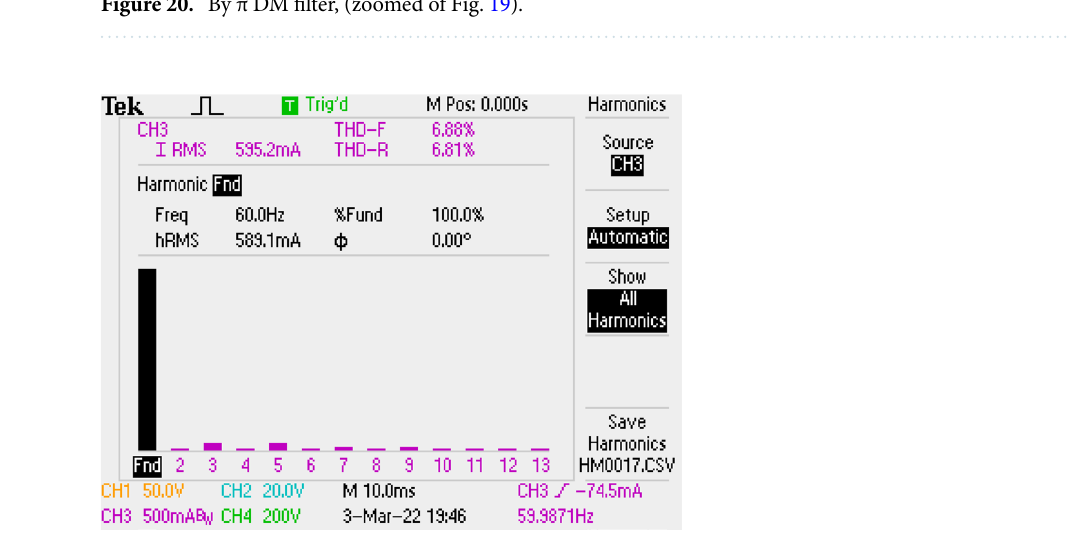
Figure 21. By π DM filter, grid current